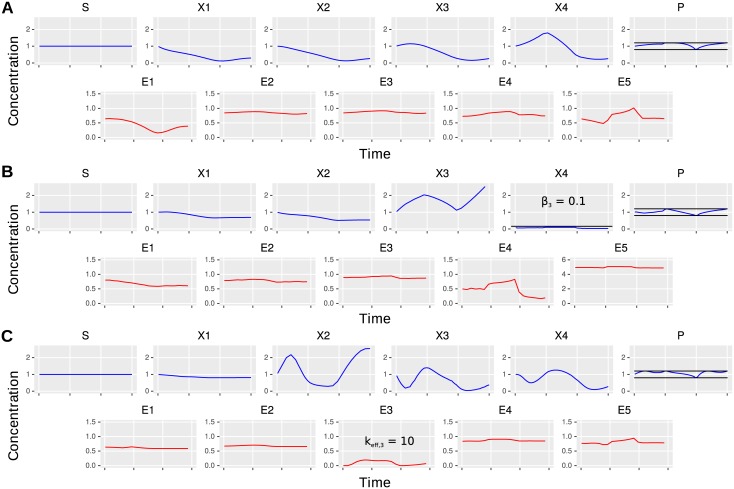
Comparison of optimal regulatory programs.(A) Optimal time-course of enzyme (in red) and intermediate (in blue) concentrations for σ = 1/30, uniform kinetics and no toxicity. (B) Optimal solution for the same parameters apart the low toxicity threshold β4 = 0.1 of intermediate X4. (C) Again the same parameters as in (A) apart the highly efficient third enzyme keff,3 = 10. Threshold are depicted as black lines and the arbitrary time horizon ranging from 0 to 30 is discarded for lucidity.